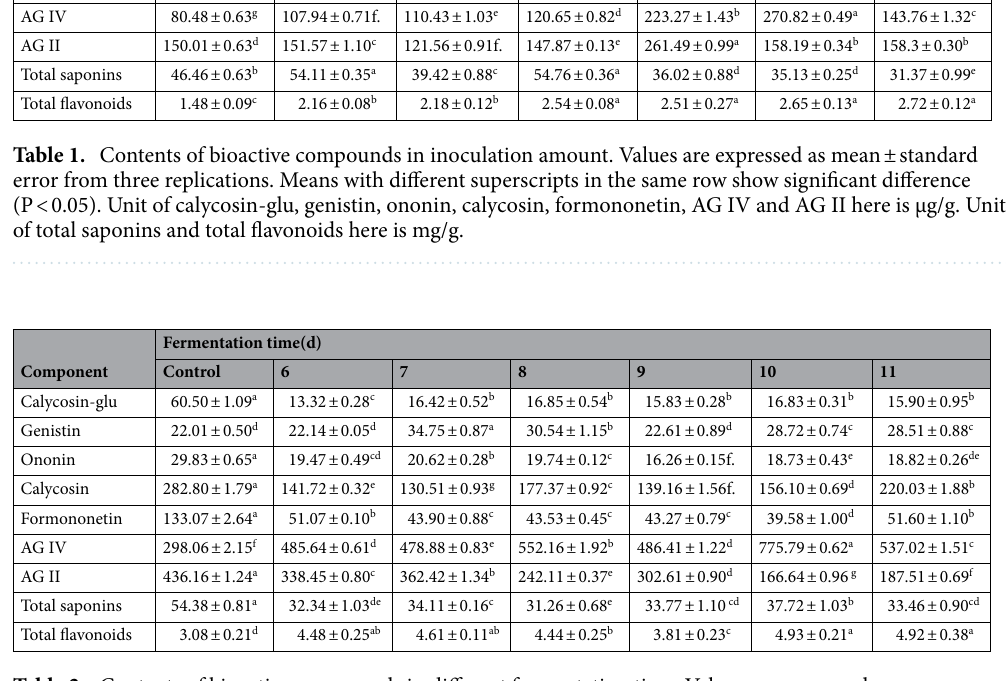
Table 2. Contents of bioactive compounds in different fermentation time. Values are expressed as mean ± standard error from three replications. Means with different superscripts in the same row show significant difference (P < 0.05). Unit of calycosin-glu, genistin, ononin, calycosin, formononetin, AG IV and AG II here is μg/g. Unit of total saponins and total flavonoids here is